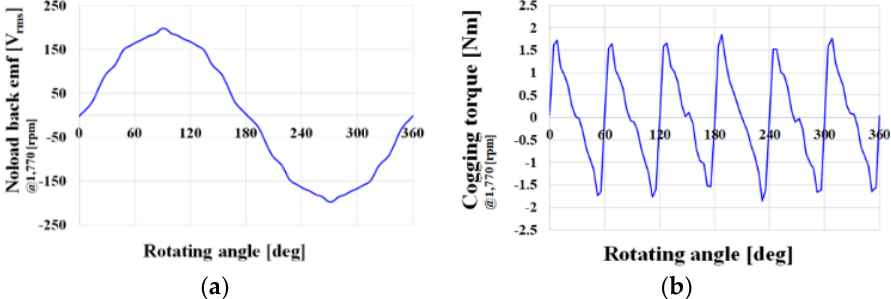
Figure 4. Back emf and cogging torque waveforms of the conventional model; ( a ) no-load back emf; ( b ) cogging torque.